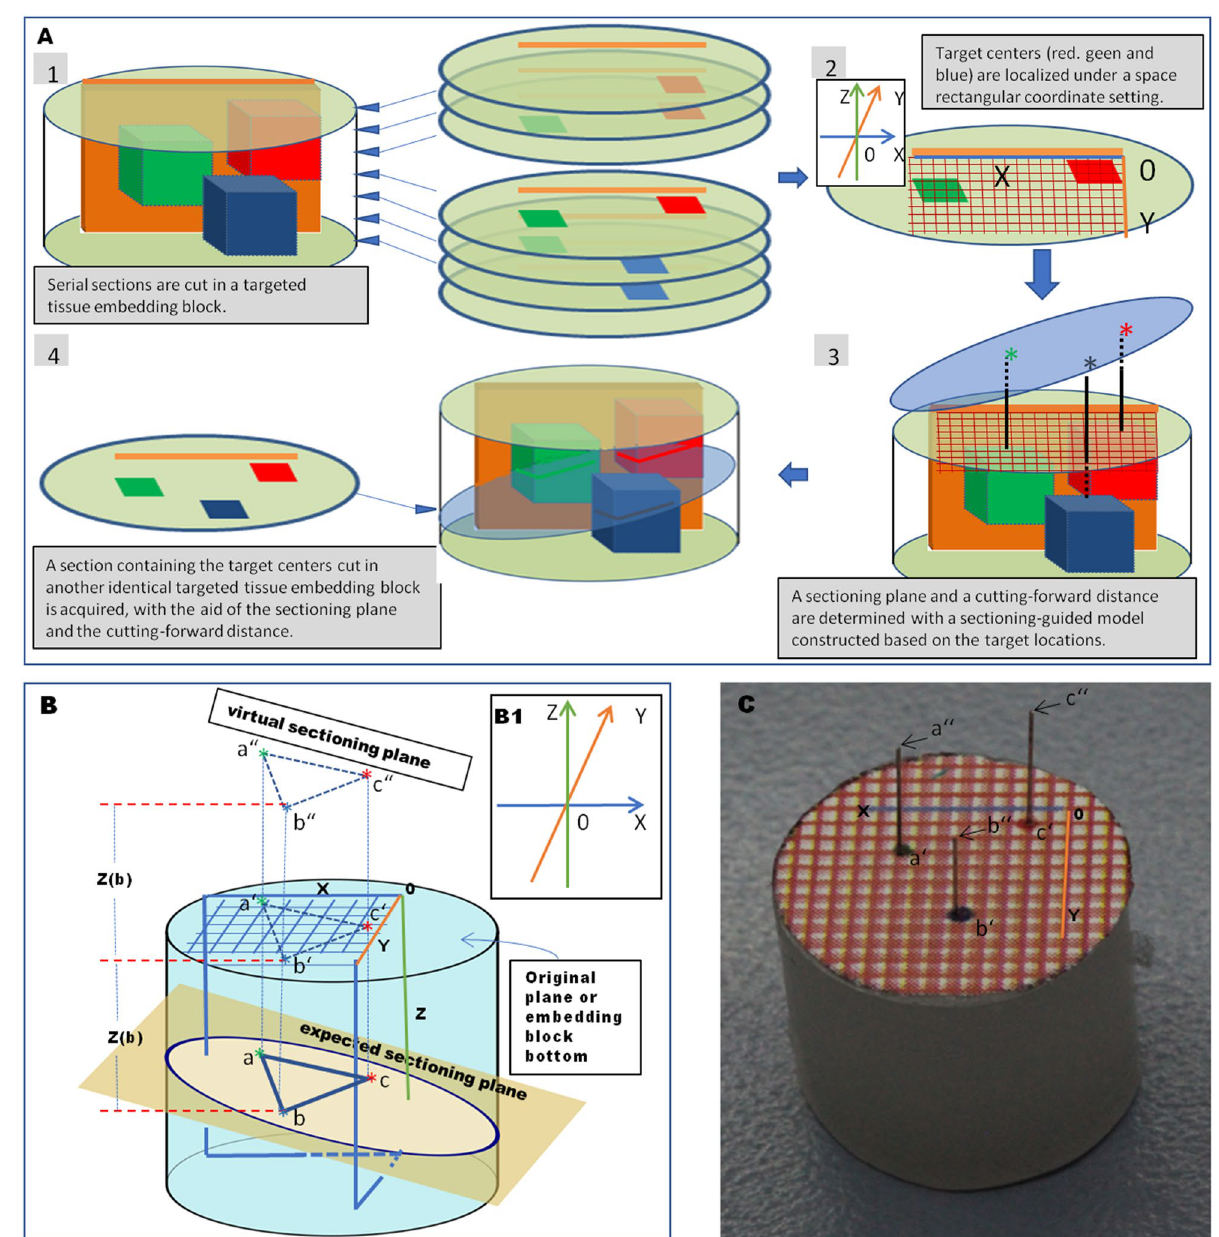
Figure 1. Experimental flow chart and fundamentals for determination of a sectioning plane and cutting- forward distance. ( A ). An experimental flow chart of 4 steps. ( B ). A three-targeted model (embedding block) is created. The 3D central positions of the three targets are a (− X a, − Y a, − Z a ), b (− X b, − Y b, − Z b ), and c (− X c, − Y c, − Z c ). A sectioning plane (light yellow) that hits those three target centers (a, b, and c) is required (expected sectioning plane). A suppositional cutting plane—a‘-b‘-c‘ is parallel to the expected sectioning plane—a-b-c and the virtual sectioning plane—a“− b“− c“ with an interval of Z(b) (in the supposition of the lowest value of − Z b among three Z values— − Z a , − Z b and − Z c ). The central spatial positions in the virtual plane are [− X a, − Y a, (2 × Z b − Z a )] for a“, [− X b, − Y b, Z b ] for b“ and [− X c, − Y c, (2 × Z b − Z c )] for c“. ( C ). A sectioning-guided model is made of an identical paraffin block to ( B ) in size and with the virtual sectioning plane (a”− b”− c”) formed by the tips of three needles based on the corresponding central positions of the distances between expected (predetermined from the sectioning-guided model) and actual paired data-in blocks was found (Table 2). The overall coefficient of variation for four runs on different days was rather small (0.068, for actual; and 0.0445, for expected), with an arrangement of 0.05–0.08 for actual measurements. Comparisons with Student paired T-tests resulted in no statistical significance (N = 12, p > 0.192 of 2-tailed). With the method, we successfully acquired the section at the place of the expected cutting-forward distance, which contains three targets in their central or proximate positions in all the repeat experiments (N = 4) of data-in models (Fig. 2C).